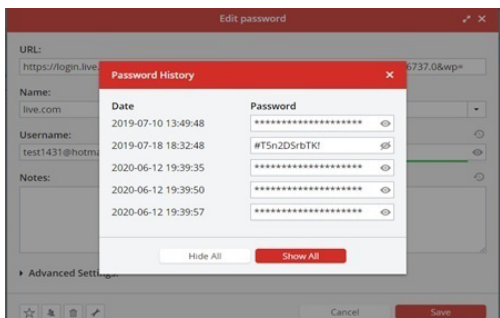
Figure A26. Old passwords stored in